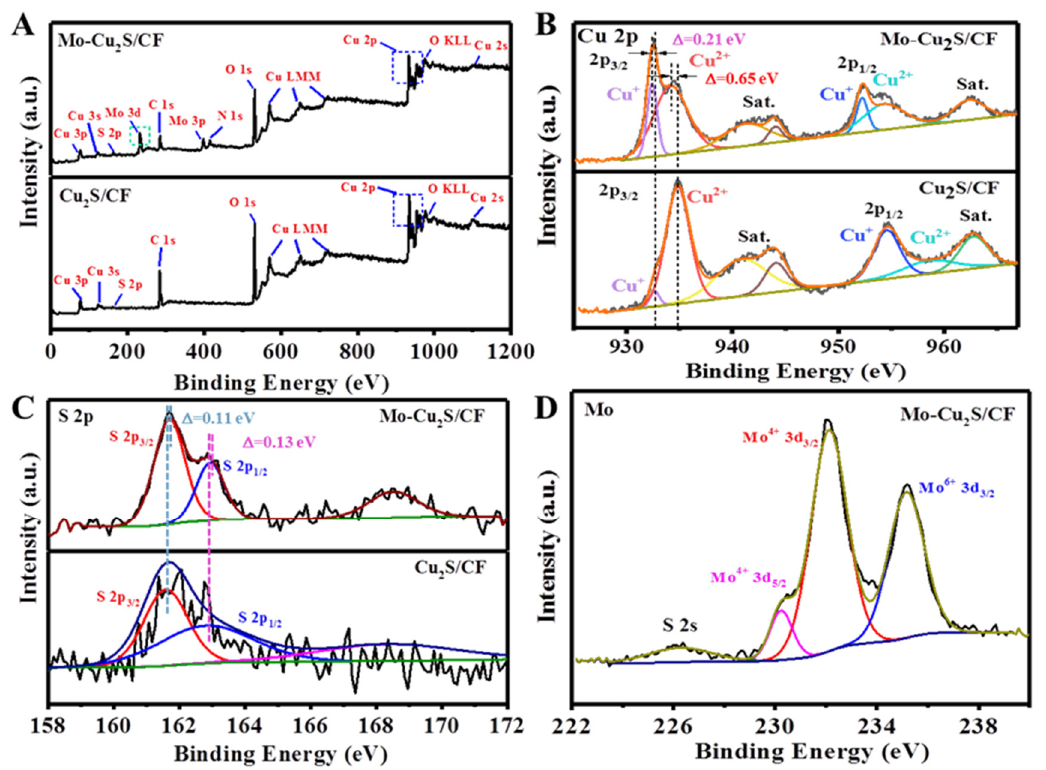
Figure 4. ( A ) Survey; ( B ) Cu 2p, ( C ) S 2p XPS spectra of Mo-Cu 2 S/CF and Cu 2 S/CF; ( D ) Mo XPS